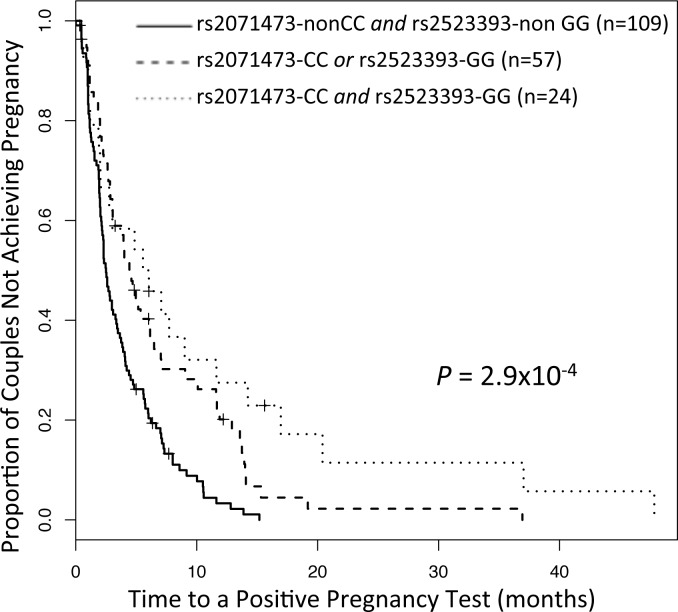
Combined analysis of rs2071473 and rs2523393 in the Hutterites.Time-to-pregnancy curves stratified by homozygosity for risk alleles at both eSNPs. The numbers in parentheses are the number of intervals included for women in each group. The number of women in each group is 64 (neither CC nor GG), 37 (CC or GG) and 15 (CC and GG).